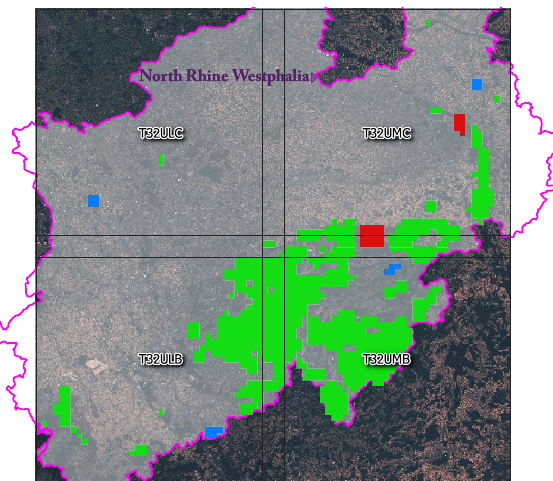
Figure 2. Overview of the test data. For each of the four tiles a time series of about 52 images is available (the exact number of images per tile varies due to varying cloud coverage). Training areas with at least 5% of the pixels belonging to a class in DC are shown in green, validation areas in blue and test areas in red.